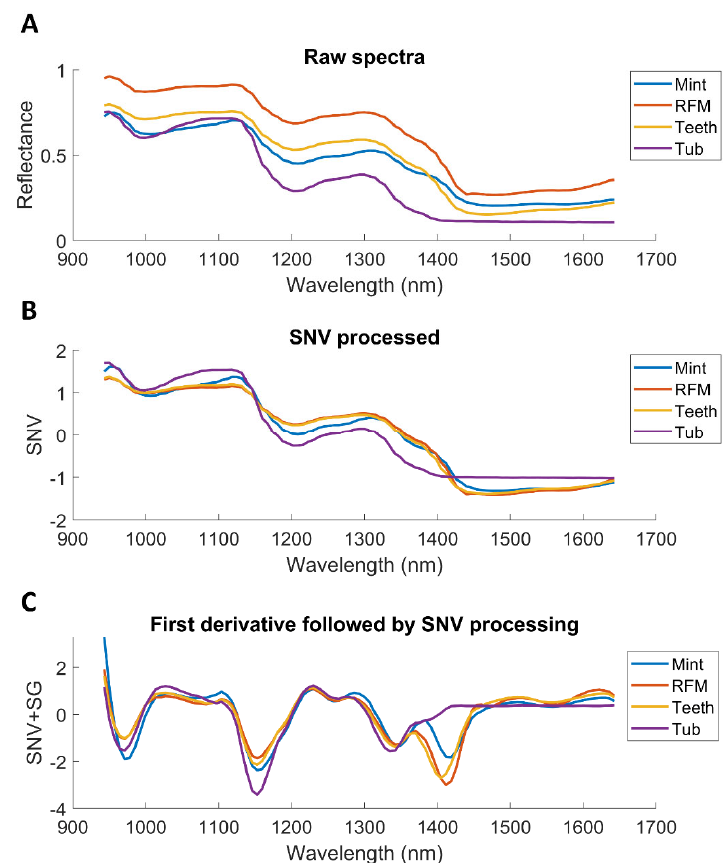
Figure 3. Influence of different spectral pre ‐ processing methods on the mean spectra of one hypercube in the training set. ( A ) Raw spectra; ( B ) Pre ‐ processed spectra with standard normal variate (SNV); ( C ) First derivative spectra (Saviztky ‐ Golay with a window size of 11 and third order polynomial degree) followed by